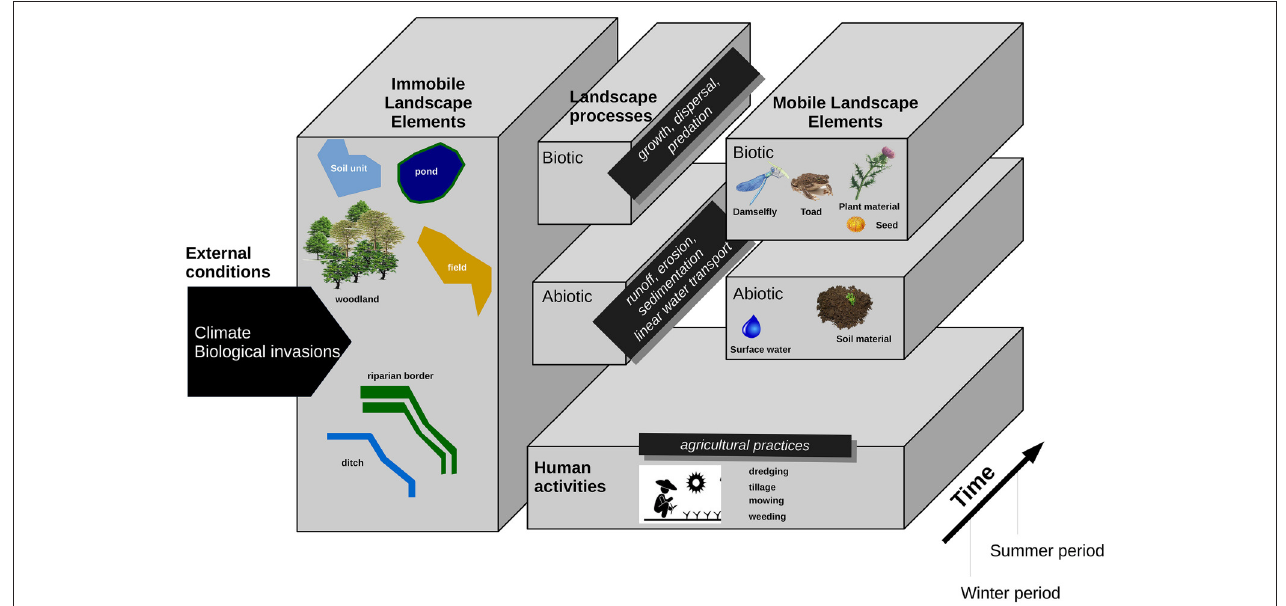
FIGURE 1 | Classification of time-variant landscape mosaics composed of six immobile landscape elements (ILE) on which act (i) three biotic and four abiotic landscape processes associated with (ii) six mobile landscape elements (MLE), all being impacted by (iii) four human activities and (iv) two external